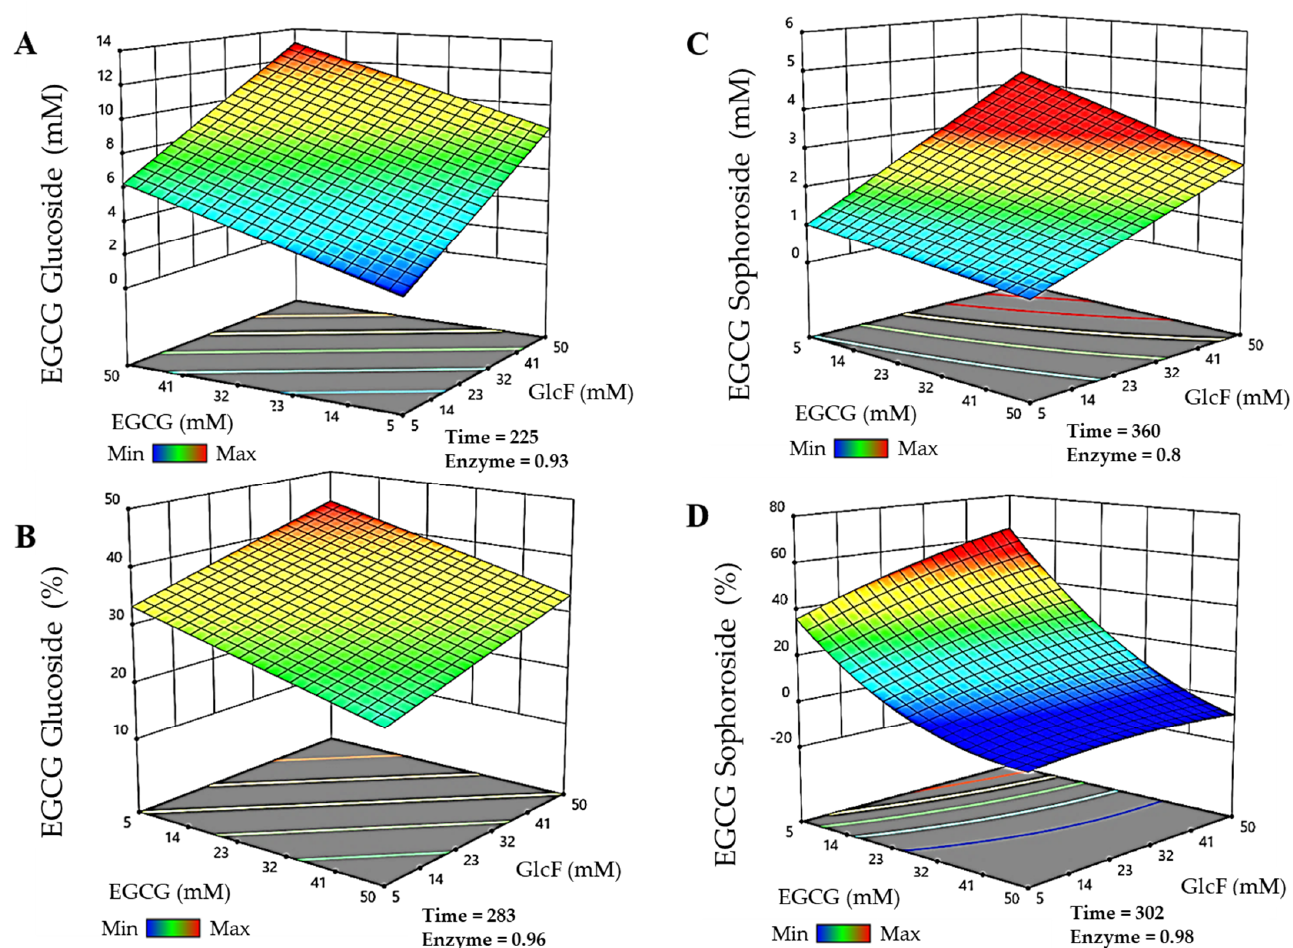
Figure 2. RSM prediction of the most efficient reactions catalyzed by the glycosynthase BGL-1-E521G, represented in three-dimensional surfaces. ( A ) Maximum production of epigallocatechin gallate 5″-O-β- D -glucopyranoside. ( B ) Maximum conversion of epigallocatechin gallate 5″-O-β- D -glucopyranoside. ( C ) Maximum production of epigallocatechin gallate 5″-O-β- D -sophoropyranoside. ( D ) Maximum conversion of epigallocatechin gallate 5″-O-β- D -sophoropyranoside. Time is represented in minutes. Enzyme concentration is given in g/L. The color code represents the production/conversion range from minimum (blue) to maximum (red).